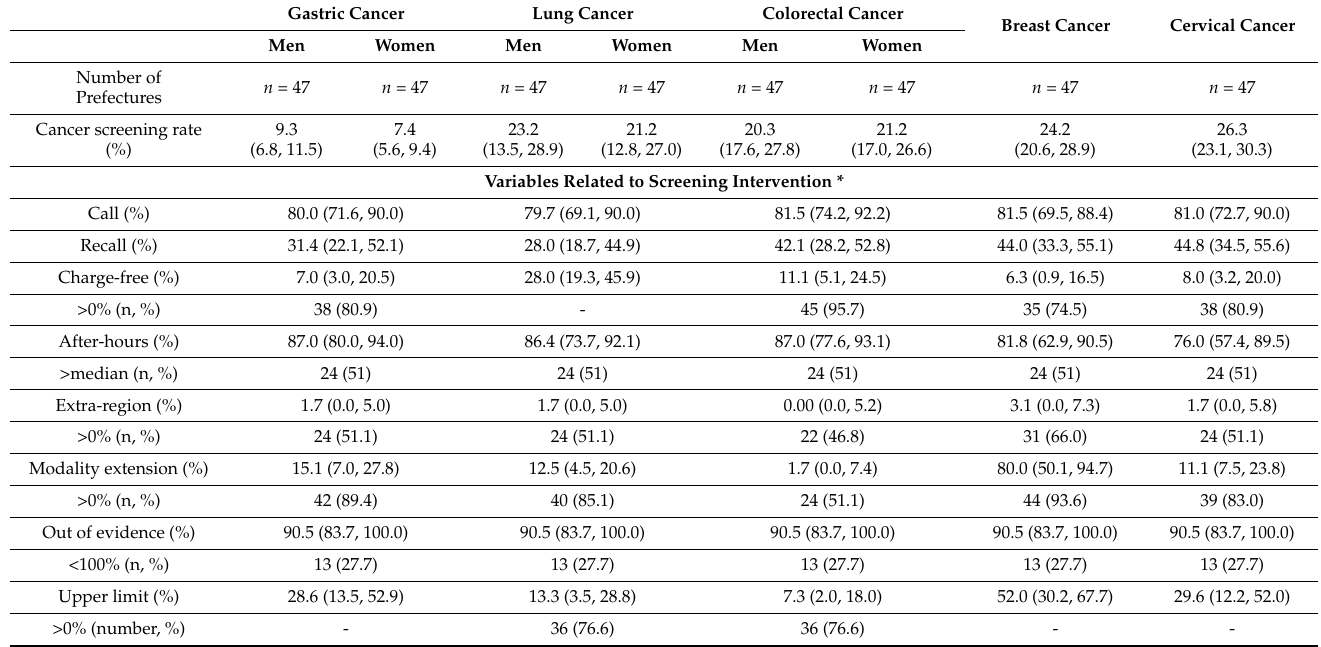
Table 1. Description of the screening rates and variables affecting screening interventions across 47 prefectures used in the analysis.